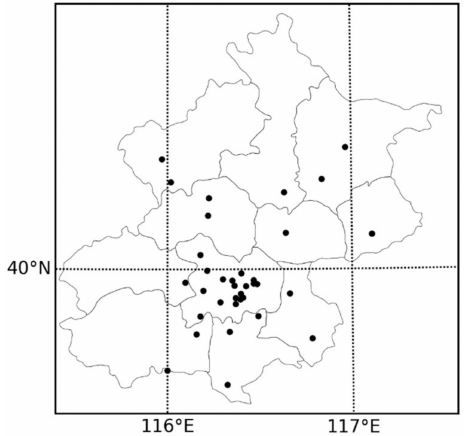
Figure 1. Distribution map of monitoring stations in